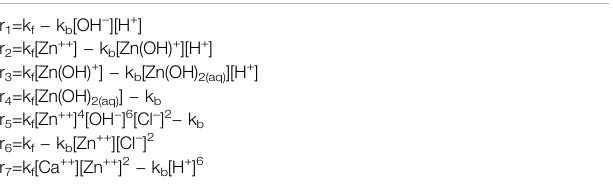
Frontiers in Materials |